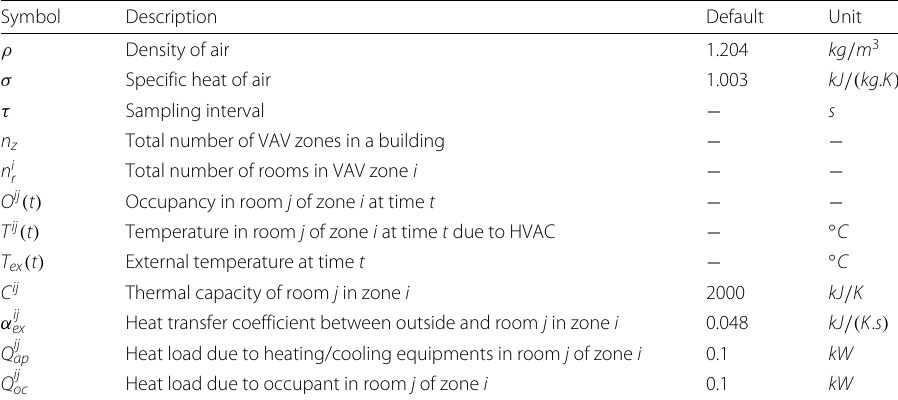
Table 2 List of symbols used in the thermal model